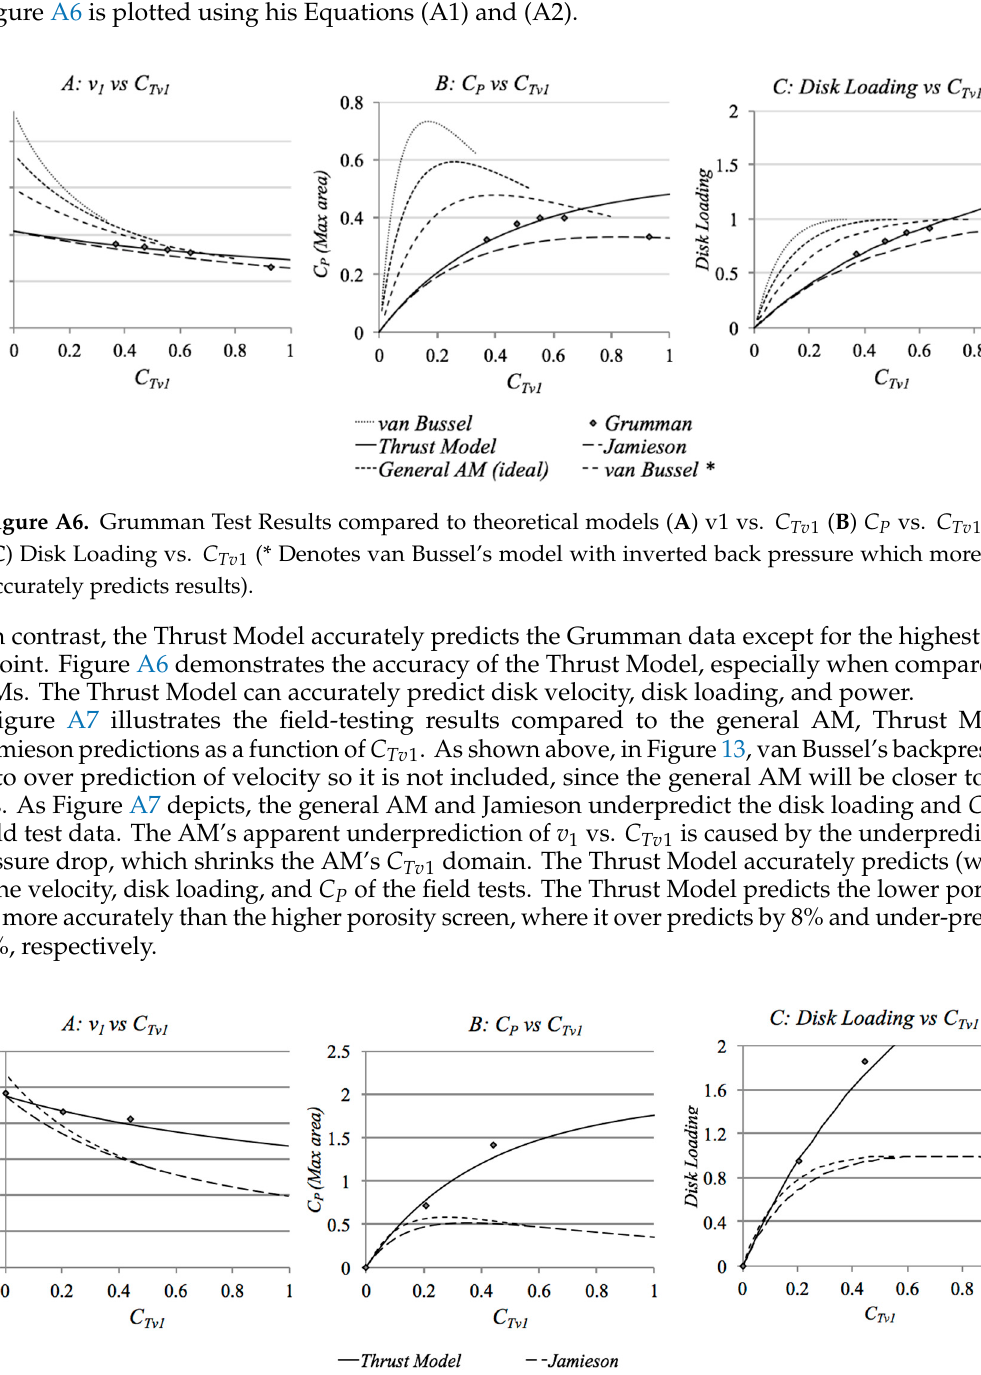
30 of 32 Figure A5. General AM and Thrust Model predictions of v1 and C P vs. C Tv 1 in a tube ( β = 1). Figure A5A–C depicts the disk velocity, C P , and disk loading for the Grumman experiment, the general AM prediction, the Thrust model prediction, Jamieson’s prediction, van Bussel’s prediction, and van Bussel’s prediction if his γ variable was inverted. WP was not plotted due to its similarity to Jamieson’s model. To note, when the Thrust Model is non-dimensionalized with disk velocity, as the disk velocity approaches zero, the C Tv 1 approaches infinity. In contrast, models like van Bussel are